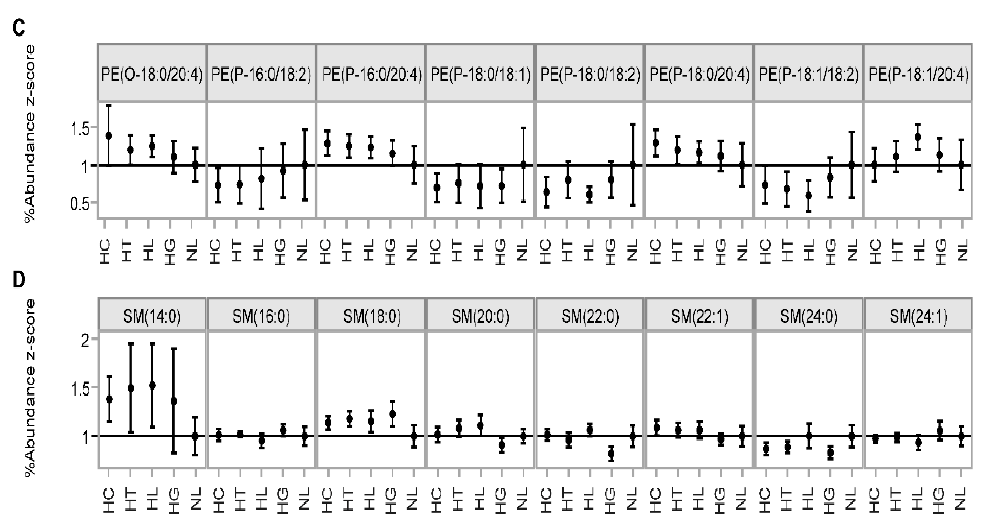
Figure 2. Comparison of %Abundances of lipid species by odd-chain, SFA/MUFA, DUFA, and PUFA containing sub-classes, normalized and compared to the NL group. Sum %Abundance by lipid classes ( A ), sum %Abundance of FA20:4 containing species ( B ), %Abundance of individual PE species ( C ) and SM species ( D ). Error bars represent confidence intervals. ( C ) and SM species ( D ). Error bars represent confidence intervals.